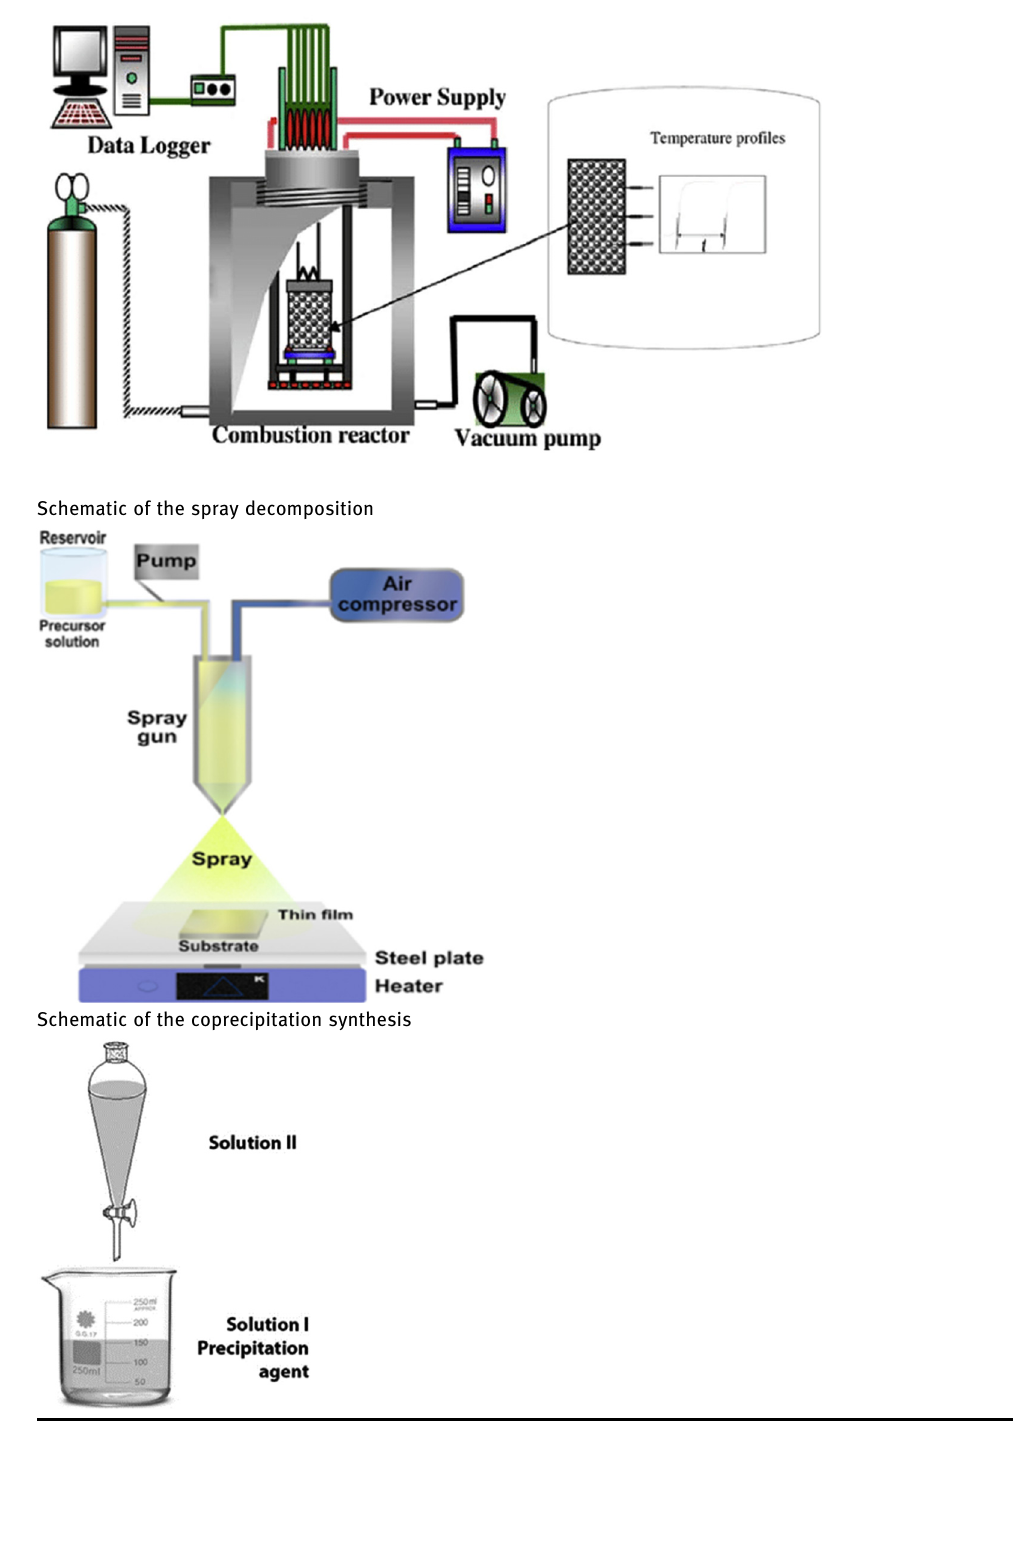
Schematic of SHS